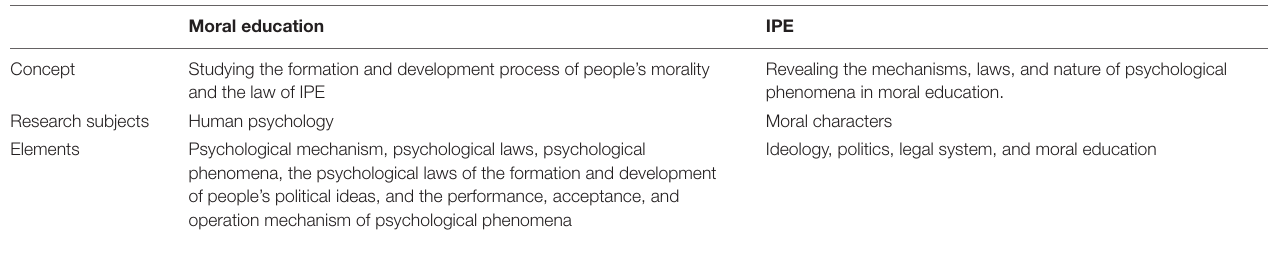
TABLE 1 | Difference between moral education and